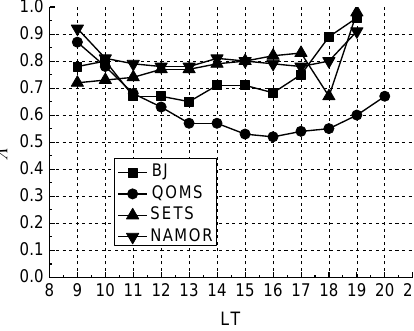
Fig. 1. Diurnal variation of evaporative fraction ( 3) at four stations Fig.1 Diurnal variation of evaporative fraction ( Λ ) at four stations of the Tibetan Plateau. of the Tibetan Plateau. LT is local time, and units are LT is local time, and units are hours.